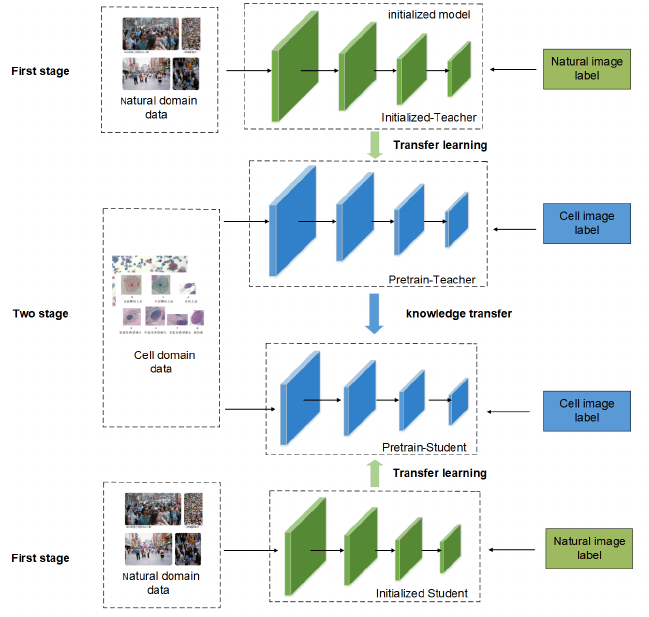
Figure 1. Schematic diagram of the transfer method framework and training